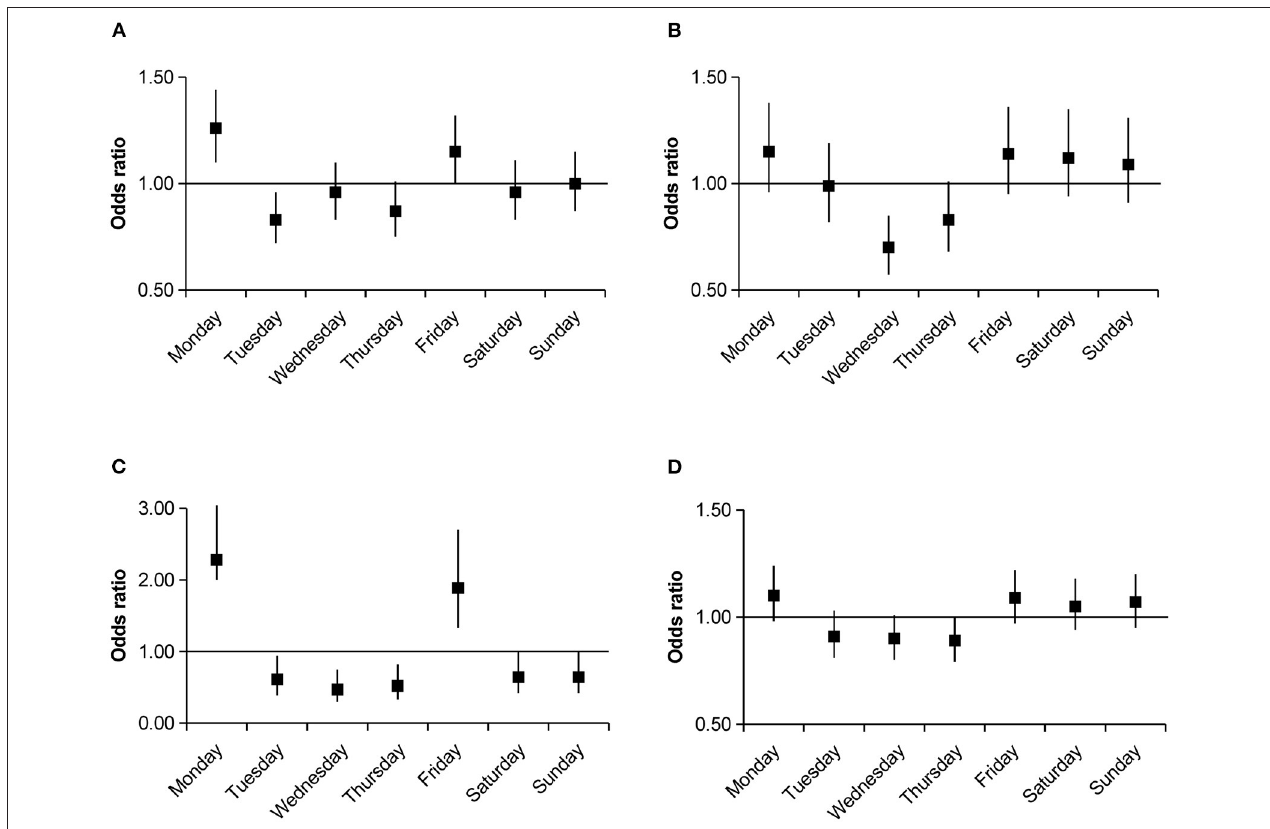
FIGURE 2 | Odds ratios with 95% confidence intervals for weekly variations of intracerebral hemorrhage occurrence stratified by hypertension and diabetes group compared with the average numbers. (A) Hypertension group. (B) Non-hypertension group. (C) Diabetes group. (D) Non-diabetes